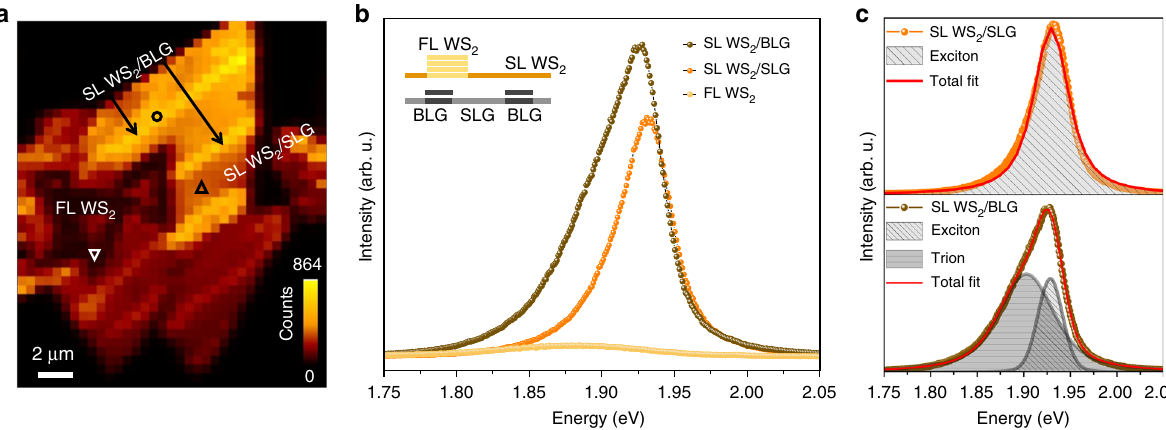
Fig. 3 Spatial distribution of PL intensity and associated spectral response. a PL intensity map of representative WS 2 island showing alternating regions of enhanced intensity and quenched signal for thick area at the centre of the island. The enhanced PL coincides with areas where WS 2 overlaps with BLG stripes, with some examples (yellow stripes) indicated by black arrows. The wider areas of lower PL intensity correspond to SL WS 2 on SLG. b Comparison of photoluminescence spectra associated with SL WS 2 on SLG, SL WS 2 on BLG and with FL WS 2 . These are extracted from the locations indicated by symbols in ( a ). c PL peak deconvolution, carried out using Lorentzian shape components, for SL WS 2 on SLG (top panel) and SL WS 2 on BLG, highlighting the appearance of the trion (bottom